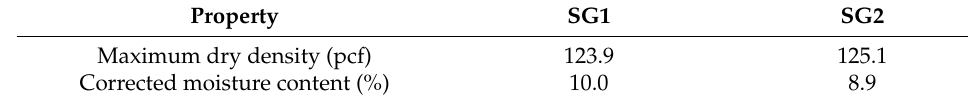
Table 2. Maximum dry density and optimum moisture content of subgrades.